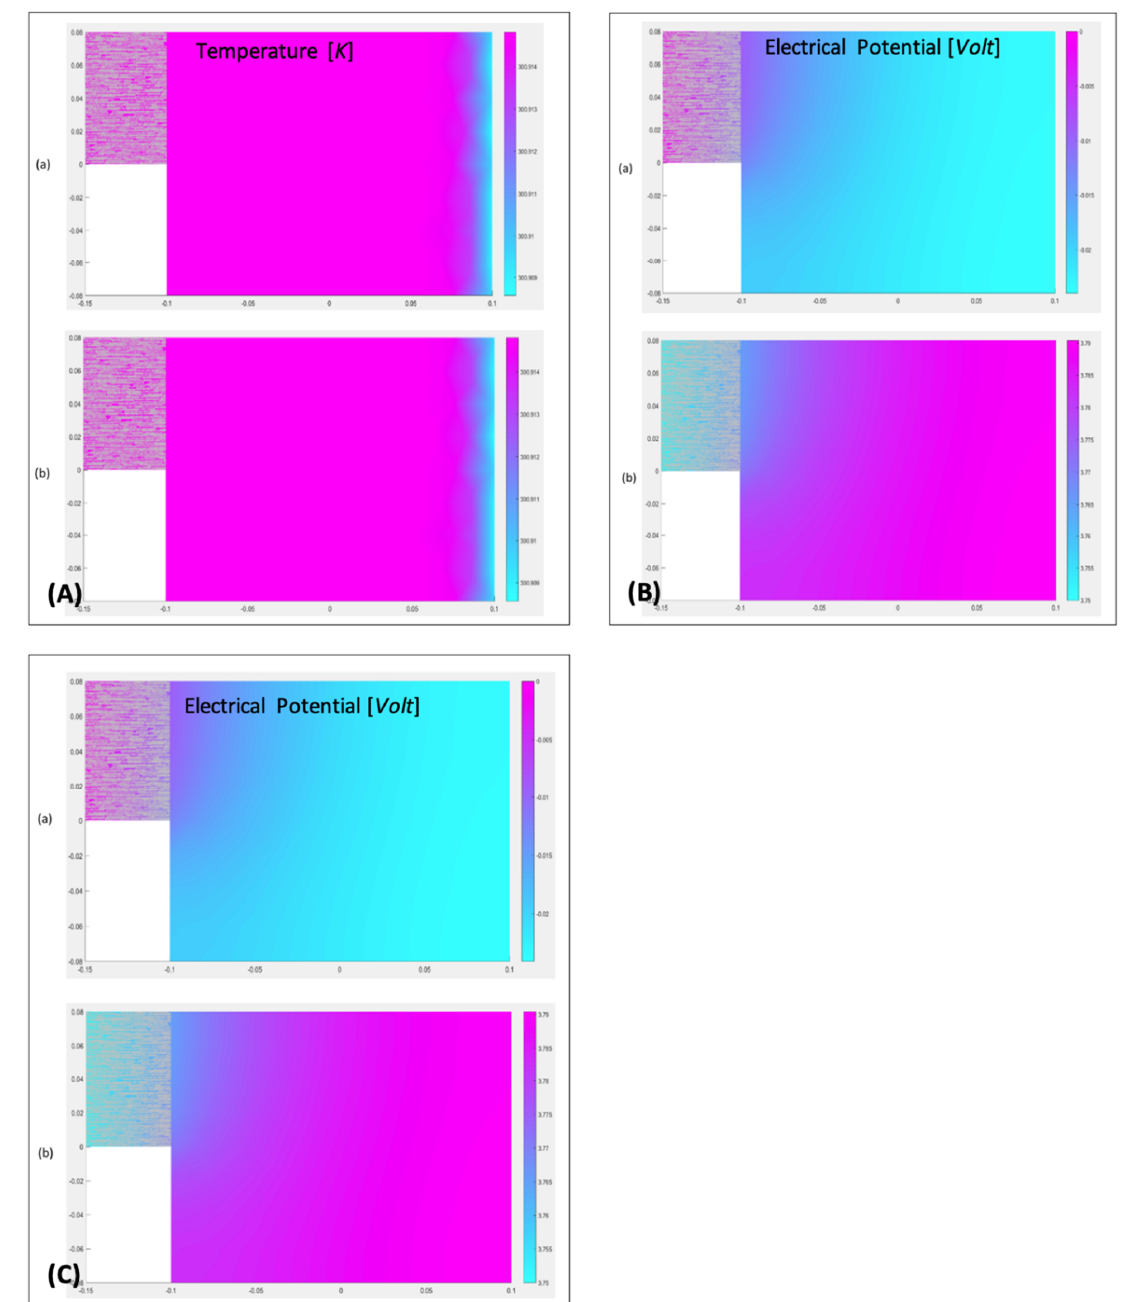
Figure 9. 2D results of temperature and electrical potential for the first simulation group . The scales show the cell dimensions as in Figure 1. (Unit: m). Color distribution as noted below. ( A ) The temperature distribution of a cell. The end far from the current collector tab has relatively lower temperature while the unevenness is growing. ( a ) GPR-based model . ( b ) Result at the 25th s. using [16]. ( a , b ) Results are identical. Color scale index cell temperature in K. ( B ) GPR model-based electrical potential distribution on the ( a ) negative plate and ( b ) positive plate. Potential is relatively higher in ( a ) and lower in ( b ) near the current collector tab area). Color scales index the electrical potentials in Volts. ( C ) Electrical potential distribution at the 25th s. using [16], which correspond to the results by our GPR models in the first simulation group as in Figure 9B. Electrical potential distribution on the ( a ) negative plate, and ( b ) positive plate of the cell in 2D. They are identical to the results in Figure 9B. Color scales index the electrical potentials in Volts . Scales indicate cell dimensions (Unit: m).